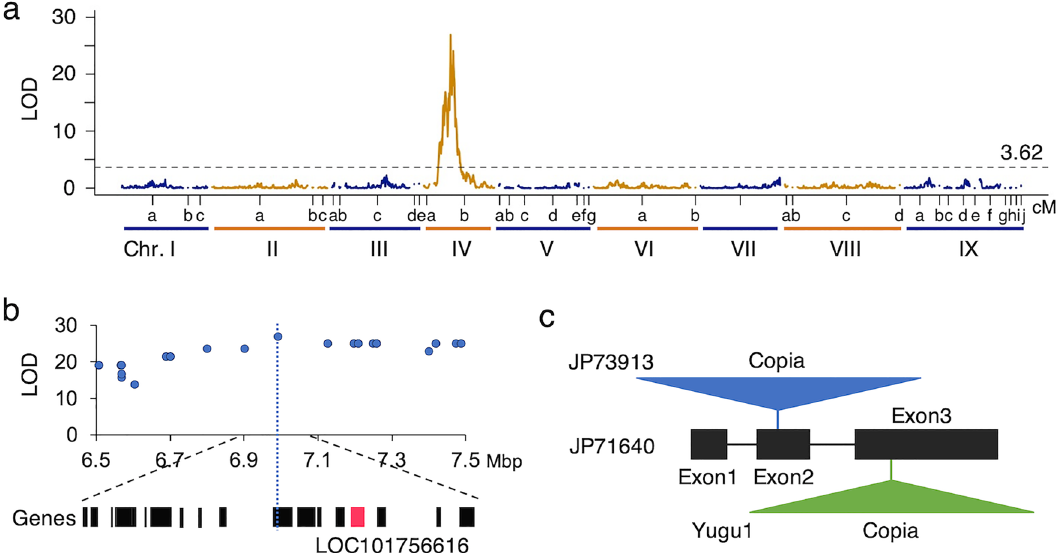
Figure 4. Analysis of leaf sheath color of the foxtail millet. ( a ) Distribution of LOD scores for the leaf sheath colors in RILs. ( b ) Enlarged view of the physical map around the marker which showed the highest LOD score. The annotated genes on the S. italica reference genome are shown at the bottom part, and the red one is C gene which is the candidate gene for leaf sheath color. ( c ) Structure of C gene for leaf sheath color. Transposable element (TE) insertions each for JP 73913 with green sheath and Yugu1 with green leaf